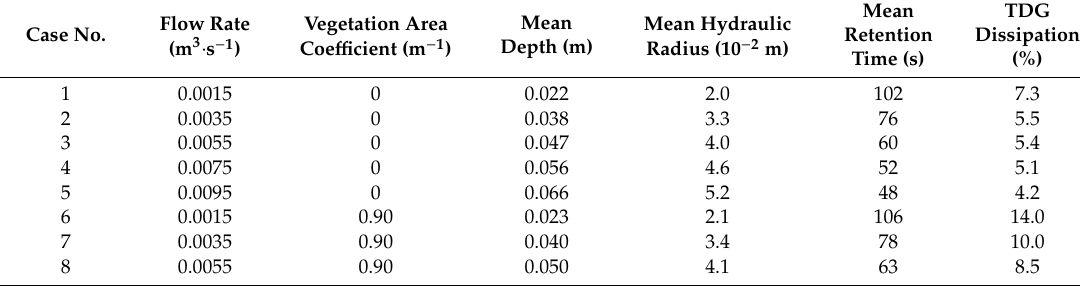
Figure 2. The arrangement of the glass columns in the flume (case 6 to case 10). Table 1. The experimental cases and results.